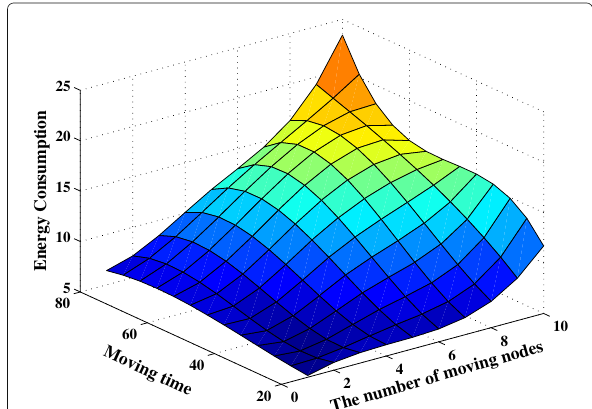
Fig. 7 The relation between energy consumption and the number of nodes, the number of moving